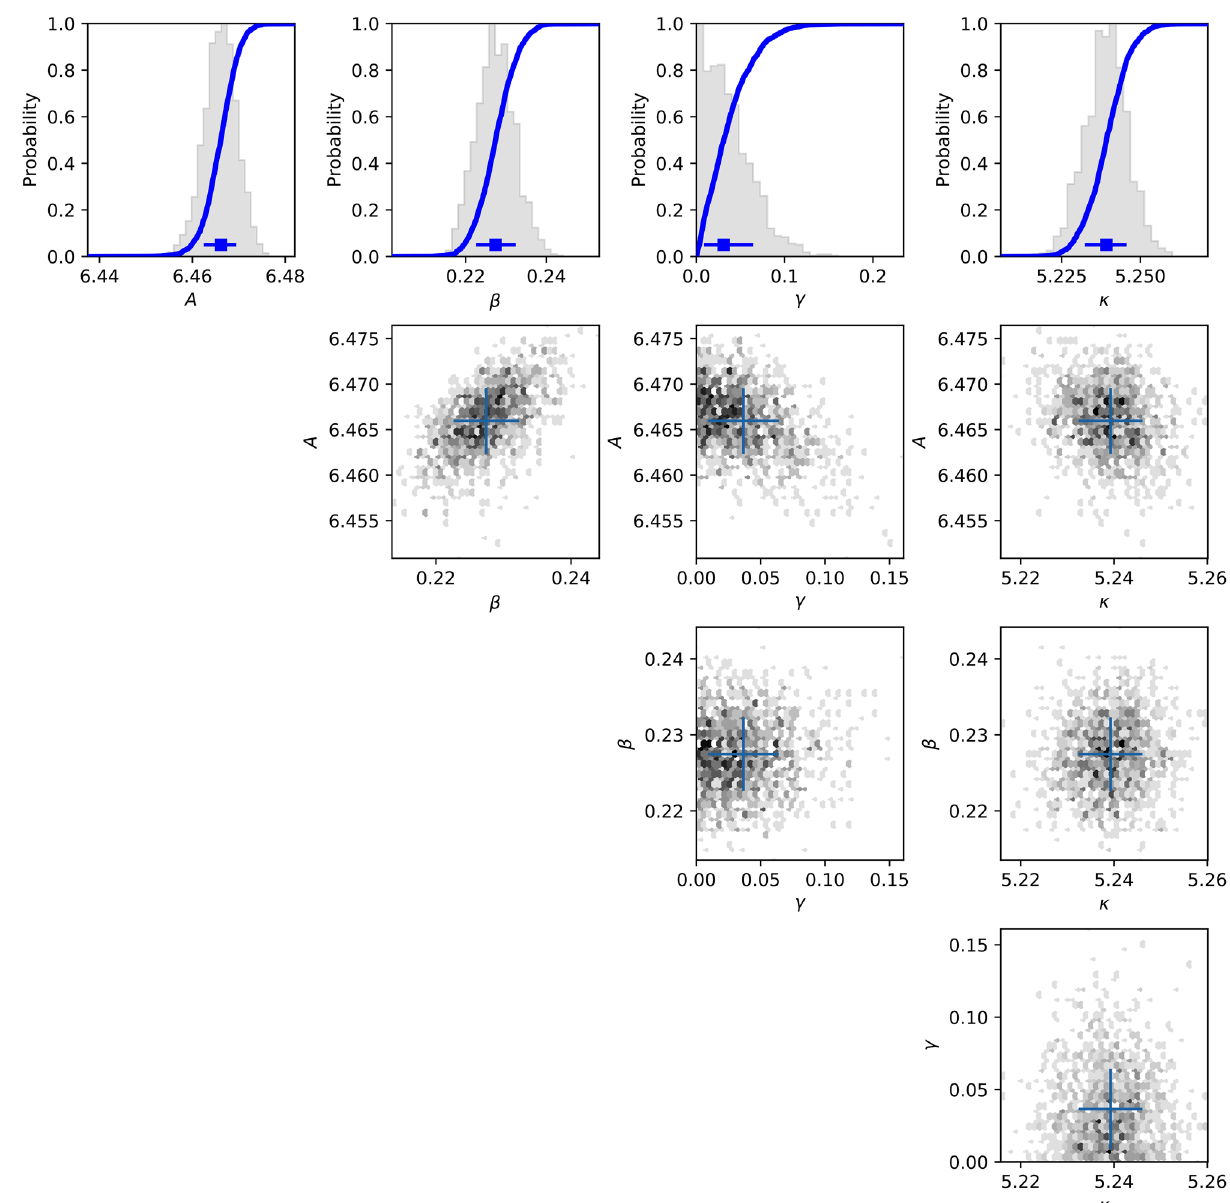
Figure 1. The posterior distribution of the fractal model parameters is shown in a corner plot of two- dimensional cuts and one- dimensional histograms for Recording 123,136 of the Killer Whale. The distribution has been marginalized over the parameters which are not shown. Blue crosses show the mode of the distribution as identified by the Multinest In both models, and for each mode there is significant cross-correlation between several parameters. In the fractal model the spectral index β , the amplitude A and the offset γ are very strongly correlated. This is not sur- prising because a change in the fitted slope may be partially offset by a change in amplitude or shape. However, it does mean that in analyzing differences between recordings the cross-correlation between parameters cannot be neglected, and it is often a good approximation to say that there is just one independent parameter. Bayesian evidence. In addition to the posterior distribution, our procedure produces the Bayesian evidence Z for each model. While the overall scale of Z is not meaningful, being tied to the choice of prior normalization, ratios of Z across different models represent ratios of the posterior probabilities of those models. That is, within the space of just ARMA and Fractal models,